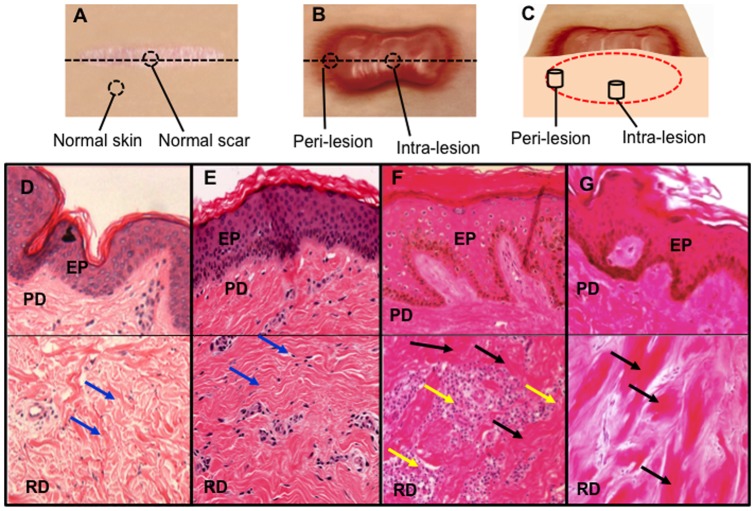
Dermal biopsy locations from healthy controls and keloid patients with corresponding histology.
A. Transverse view of biopsy locations from normal dermal scar tissue and adjacent normal dermal (non-wounded) skin from which in vitro primary cell cultures were subsequently established. B. Transverse view of marginal peri-lesional and reticular dermal intra-lesional biopsy sites from the keloid scar. C. Cross-section of keloid scar indicating depth of peri-lesional and intra-lesion biopsies. D. Representative H&E staining of tissue section from normal skin indicating organised wavy deposition of collagen (arrows). E. Representative H&E staining of tissue section from a normal scar. F. Representative H&E staining of a peri-lesional keloid tissue section indicating a thickened EP with increased cell infiltration (yellow arrow) and deposition of hyalinised collagen bundles in the RD (black arrow). G. Representative H&E staining of an intra-lesional keloid tissue section indicating thick compact hyalinised collagen bundle deposition in the RD (black arrow). EP = Epidermis, PD = Papillary dermis, RD = Reticular dermis. All the H&E micrographs (D–G) were taken at 200 magnifications.